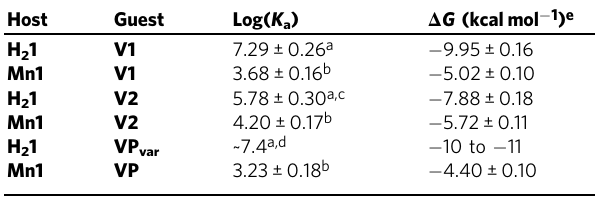
Table 1 Binding constants of host – guest